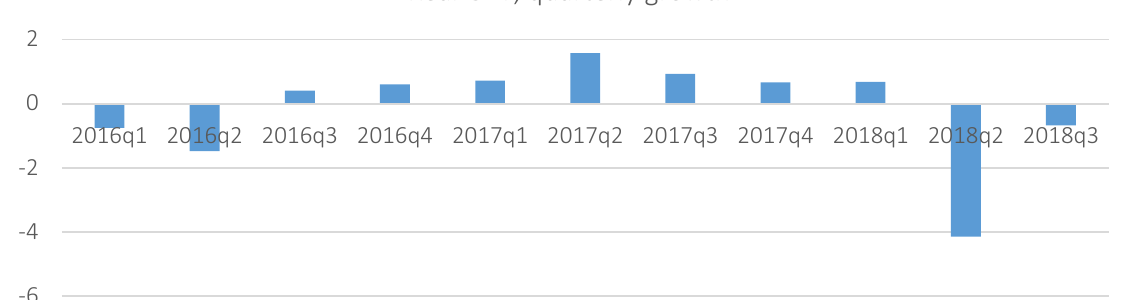
Figure 2. Quarterly growth rates of Argentina’s real GDP in 2016–2018